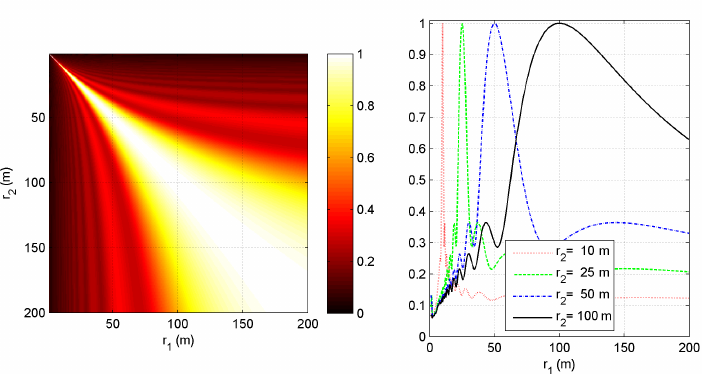
Figure 2. Two terminal correlation analysis for the λ /2 equispaced array. ( Left ) Image map with the correlation level for variable r 1 and r 2 ; ( Right ) plot of the correlation coefficient for some fixed values of r 2 .